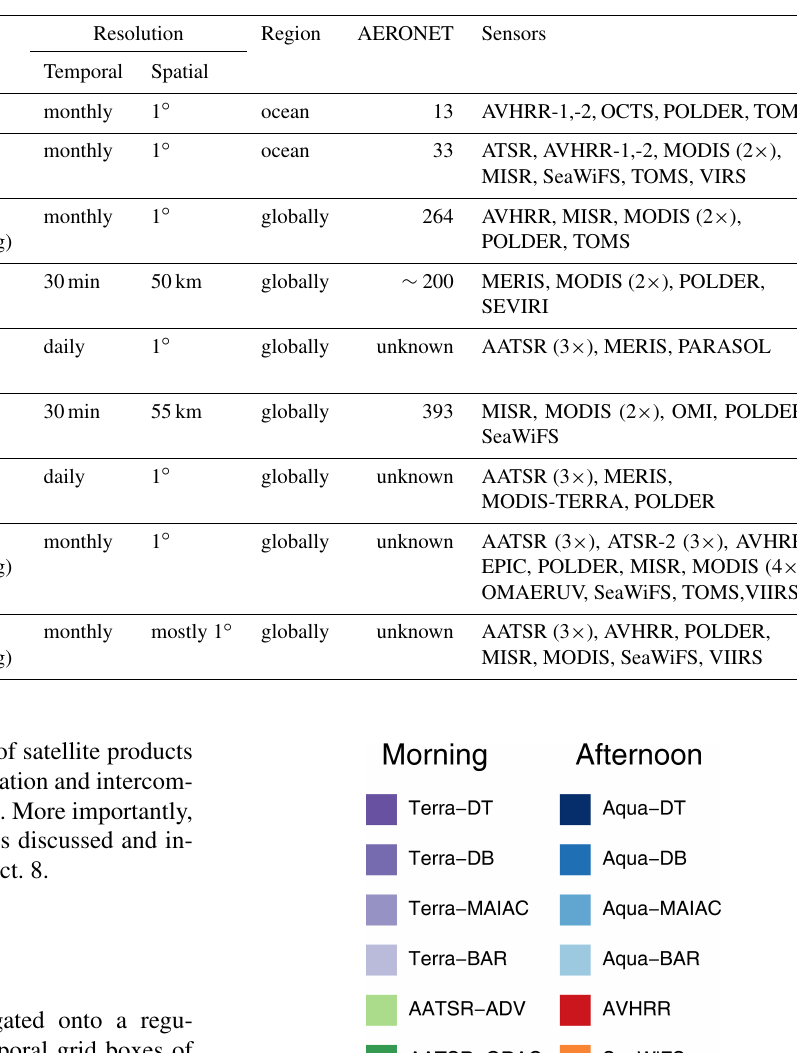
Table 1. Papers intercomparing multiple satellite datasets.